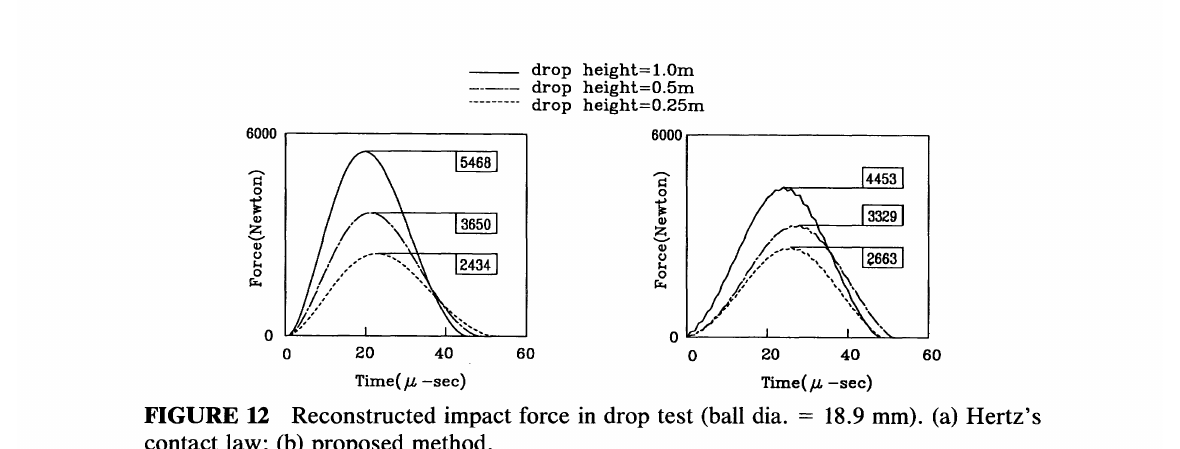
FIGURE 12 Reconstructed impact force in drop test (ball dia. = 18.9 mm). (a) Hertz's contact law; (b) proposed